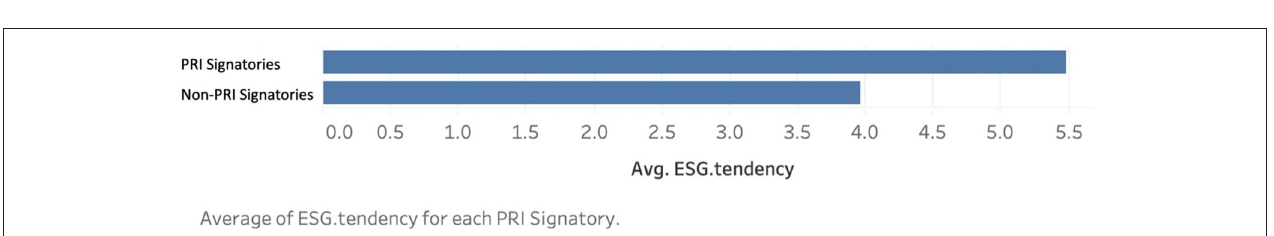
FIGURE 13 | Density ridgeline plots of ESG ownership score by the PRI signatory status.